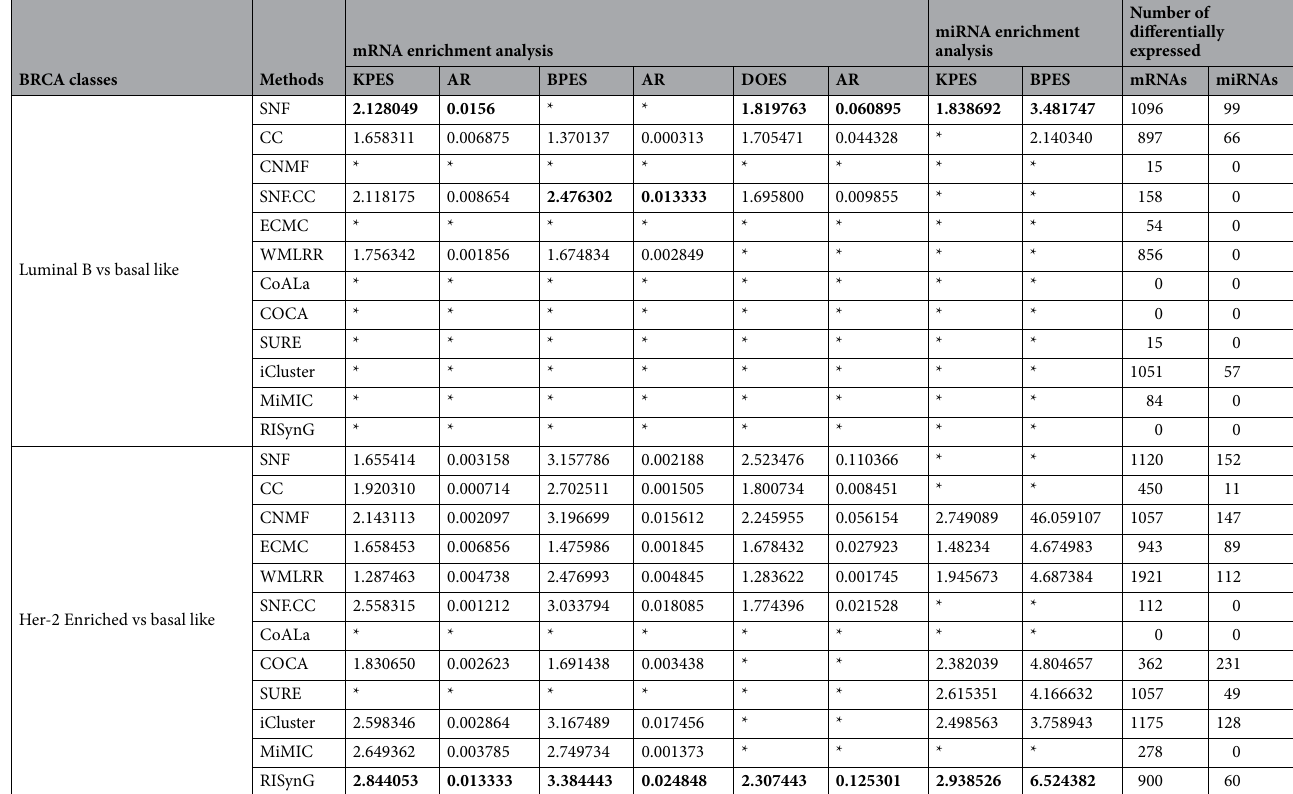
Table 6. Comparative biological analysis of BRCA dataset. The bold values indicate the best score as reported in the text.